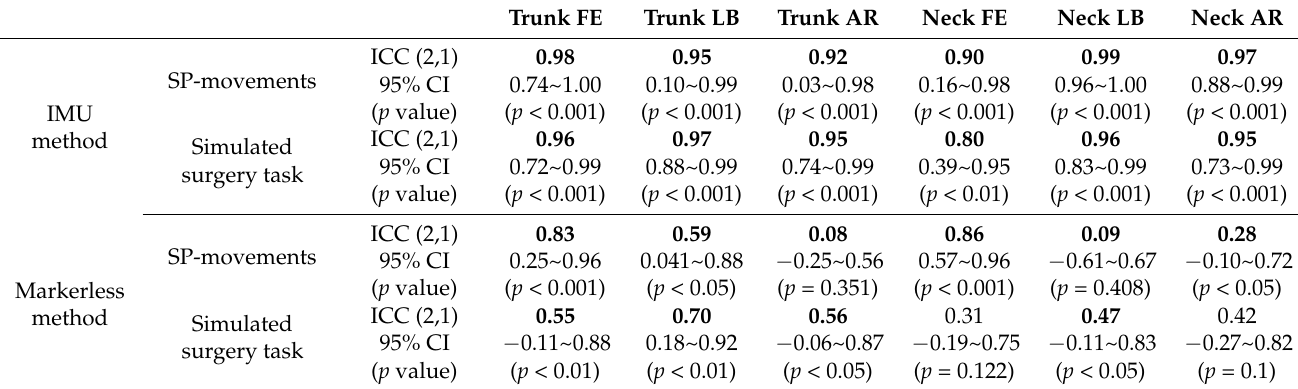
Table 3. ICC (2,1) of ROM for the IMU/Markerless